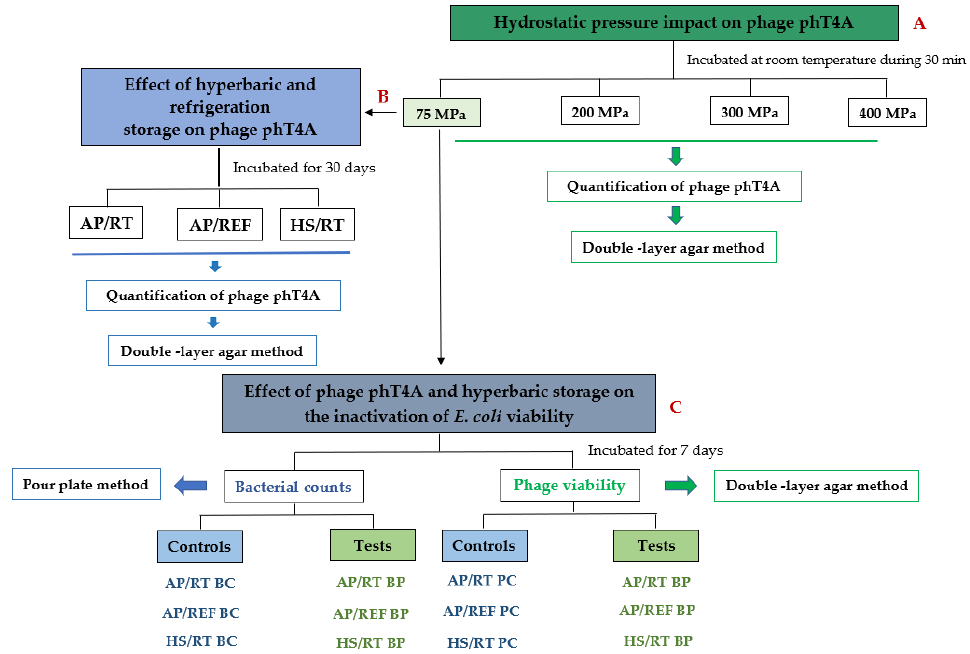
Figure 1. Schematic diagram of the experimental design. ( A ) Effect of hydrostatic pressure (75, 200, 300 and 400 MPa) and processing time on phage phT4A viability (see Section 2.3); ( B ) Phage phT4A viability under atmospheric pressure at room temperature (AP/RT) and with refrigeration (AP/REF), and under 75 MPa pressure at RT (HS/RT) for 30 days (see Section 2.4); ( C ) Effect of phage phT4A and HS on E. coli inactivation and phage phT4A viability after 7 days of storage at different conditions: under atmospheric pressure at room temperature (AP/RT) and 4 °C (AP/REF), and under a 75 MPa pressure at room temperature (HS/RT) (see Section 2.5). BC, bacteria control; PC, phage control; BP, bacteria plus phage.